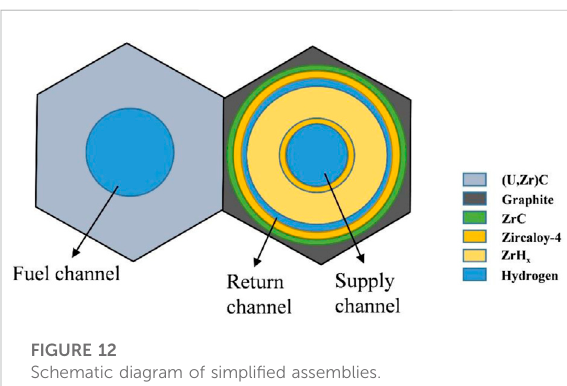
FIGURE 12 Schematic diagram of simpli fi ed